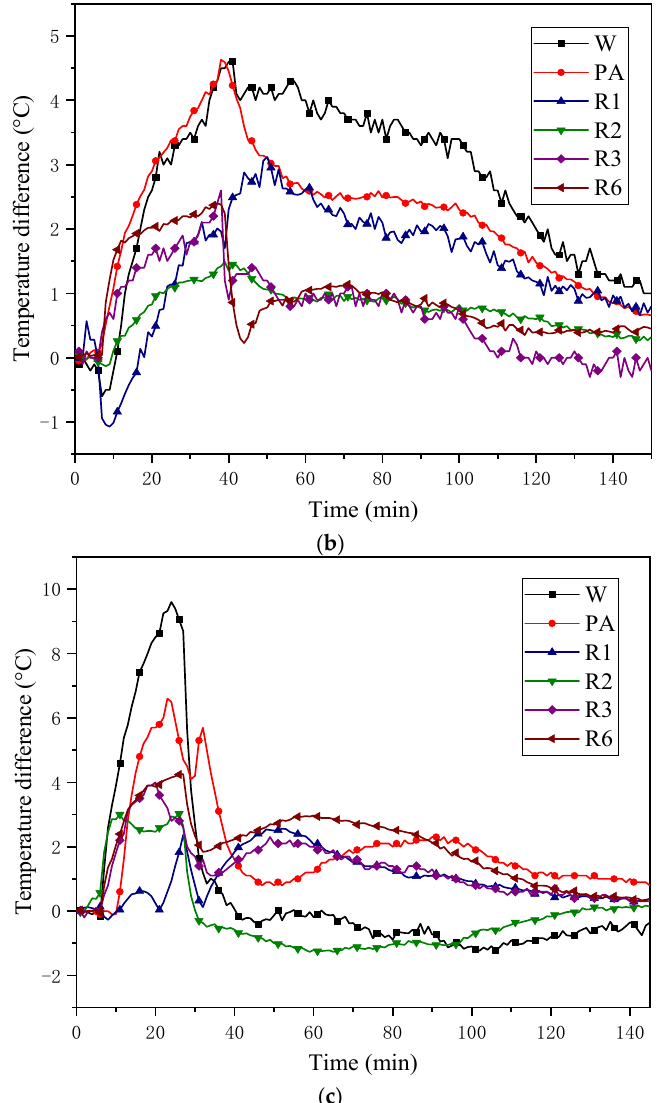
Figure 10. Temperature difference of LIB module curve ( a ) 1 C ( b ) 2 C ( c ) 3 C.